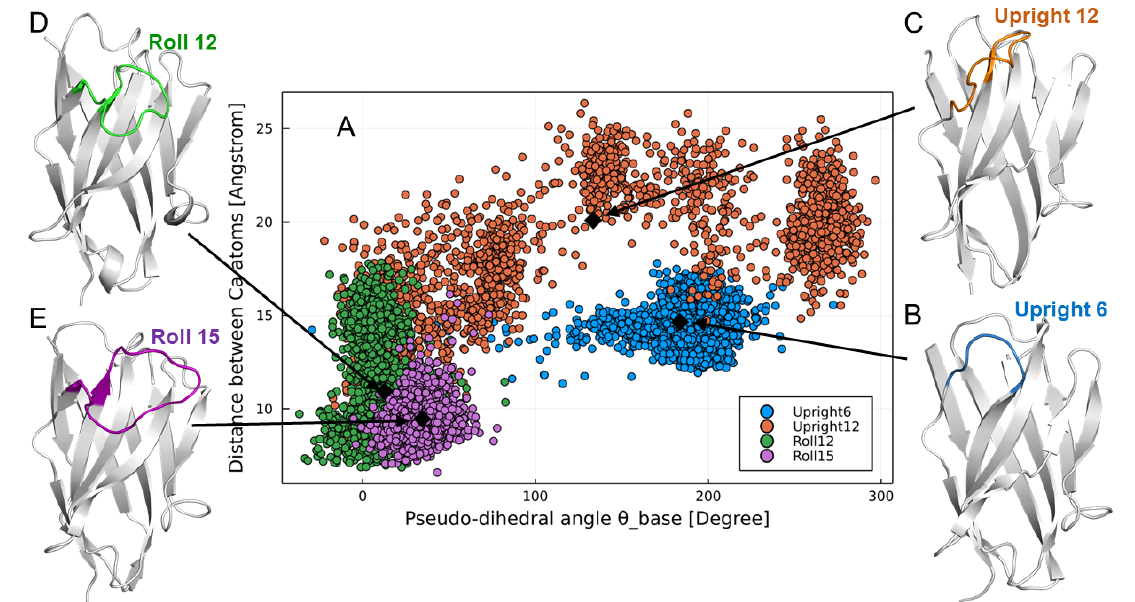
Figure 7. Molecular dynamics simulations of VHHs. ( A ) Simulated VHH structures were mapped onto the distance and the pseudo-dihedral angle space (see Figure 2). Upright 6 (blue), Upright 12 (orange), Roll 12 (green), and Roll 15 (purple) simulated structures of representative sequences are shown. A representative structure of each VHH from the closest average value in the 2D space is illustrated for Upright 6 ( B ), Upright 12 ( C ), Roll 12 ( D ), and Roll 15 ( E ).